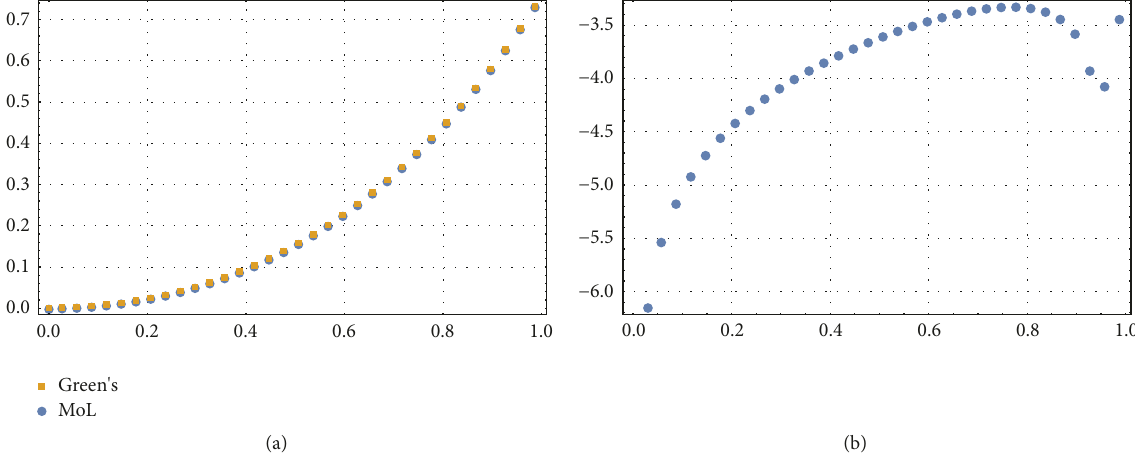
Figure 11: Discrete plot of 𝑤 and 𝑤 MoL (a) and Er (b) against 𝑡 ∈ [0,1] for 𝑓(𝑡) = 1 + 𝑡 + 𝑡 2 + 𝑡 3 : hyperbolic potential. Green’s